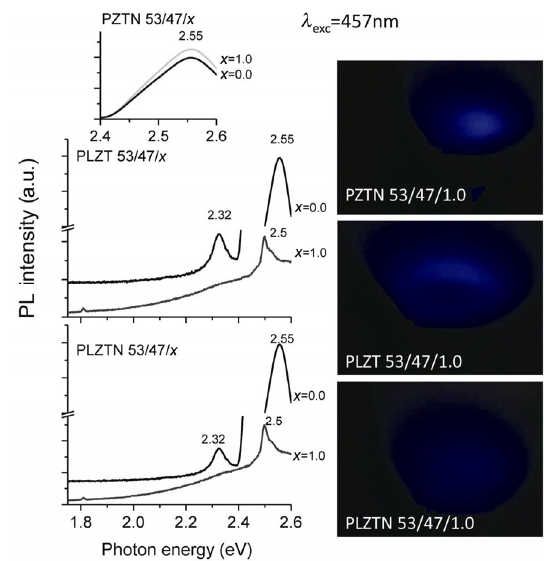
Fig. 4 PL spectra for Pb 1  3 x /2 La x (Zr 53 Ti 47 ) 1  y Nb y O 3 for x , y = 0, 0.01, excited at 457 nm. The inset shows the spectra of PZTN system